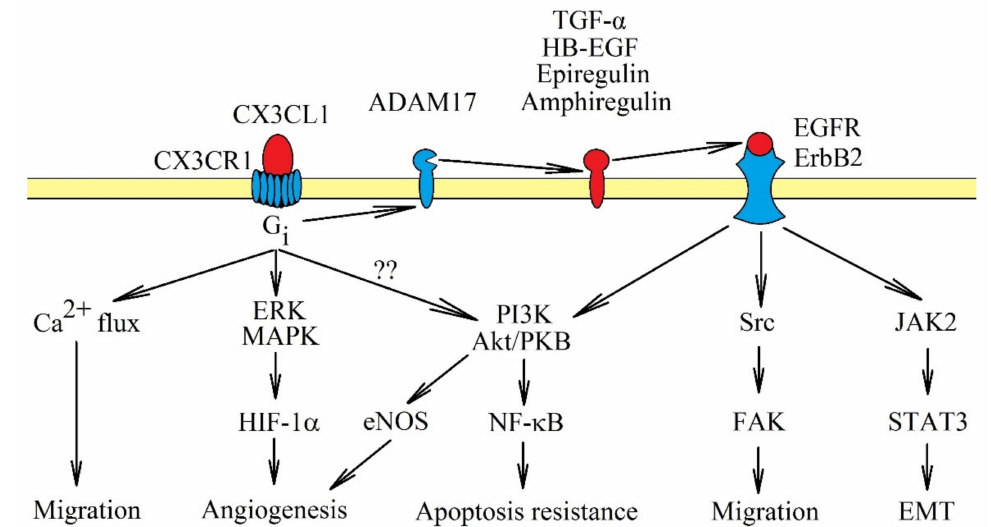
Figure 1. Signal transduction from CX3C chemokine receptor 1 (CX3CR1). The CX3CR1 receptor is a seven-transmembrane domain G protein-coupled receptor. Activation of this receptor causes signal transmission to extracellular signal-regulated kinase (ERK) mitogen-activated protein kinase (MAPK) and phosphatidylinositol-4,5-bisphosphate 3-kinase (PI3K) → Akt / protein kinase B (PKB) axis, accompanied by Ca 2 + mobilization. These pathways cause cancer cell migration and apoptosis resistance. CX3CR1 activation also activates Src → focal adhesion kinase (FAK) and janus tyrosine kinase 2 (JAK2) → signal transducer and activator of transcription 3 (STAT3), although it is likely that they are only activated indirectly. First, CX3CR1 activates tumor necrosis factor- α converting enzyme / a disintegrin and metalloproteinase 17 (TACE / ADAM17), which releases epidermal growth factor receptor (EGFR) / ErbB1 and ErbB2 receptor activators. Only after the activation of EGFR / ErbB1 and ErbB2 receptors, can Src → FAK and JAK2 → STAT3 pathways be activated as well. CX3CL1: CX3C chemokine ligand